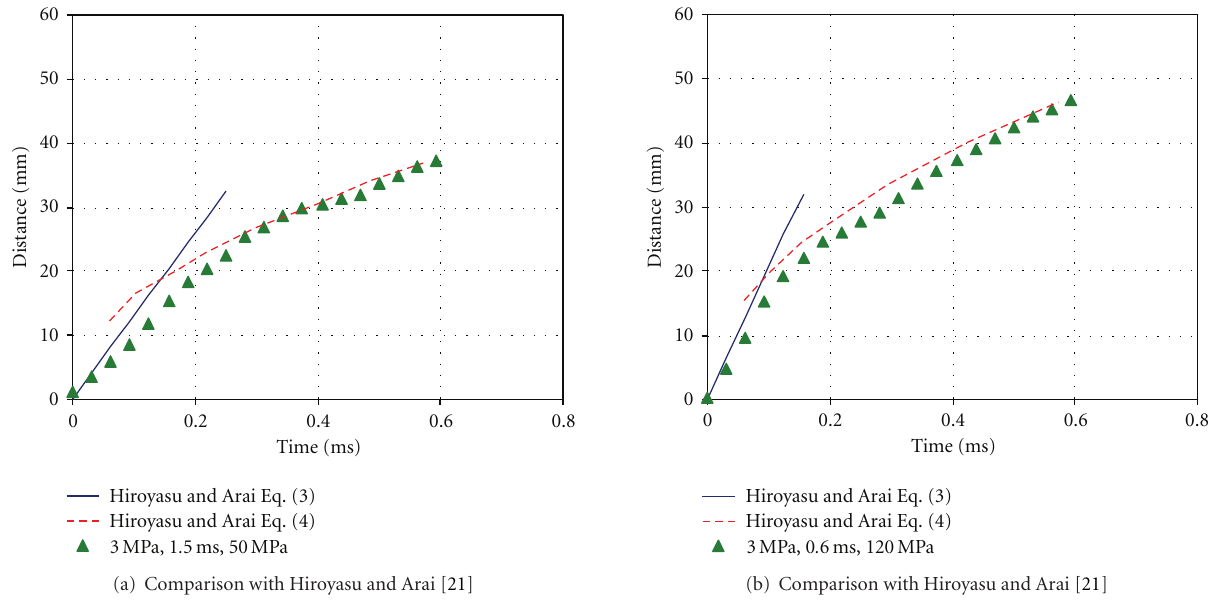
Figure 11: Experimental results of spray tip penetration and Hiroyasu and Arai model prediction, Nozzle D.